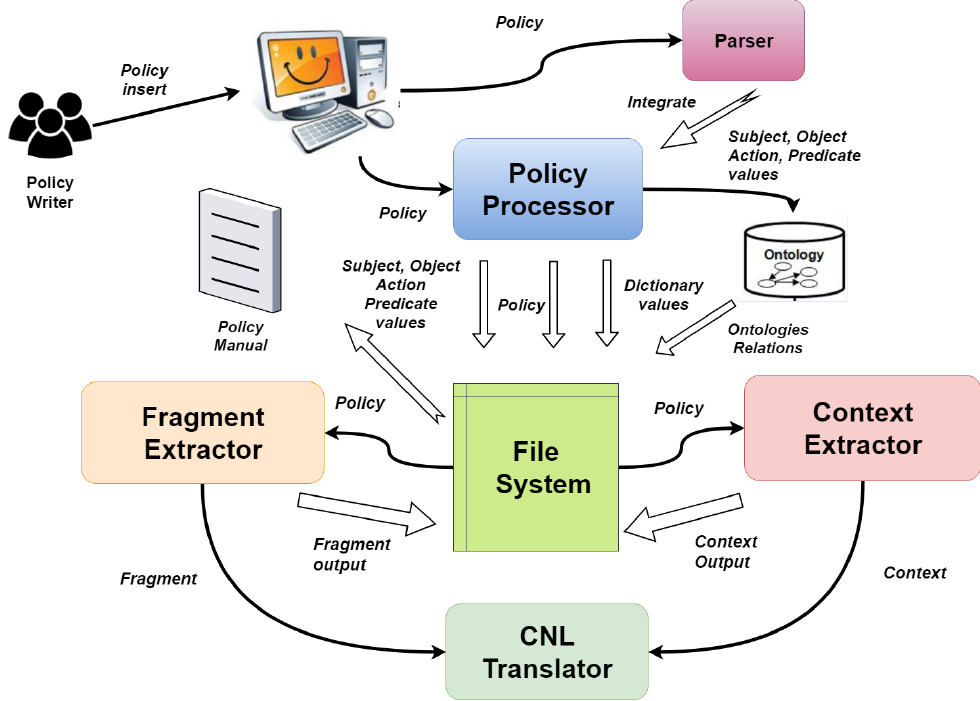
Figure 4. System architecture Natural Language Policy Translator (NLPT) 2.0